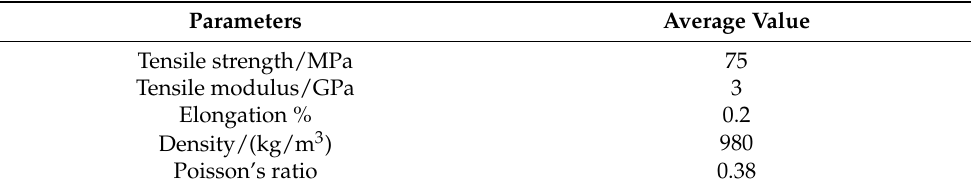
Table 2. Mechanical parameters of the epoxy resin matrix [58].